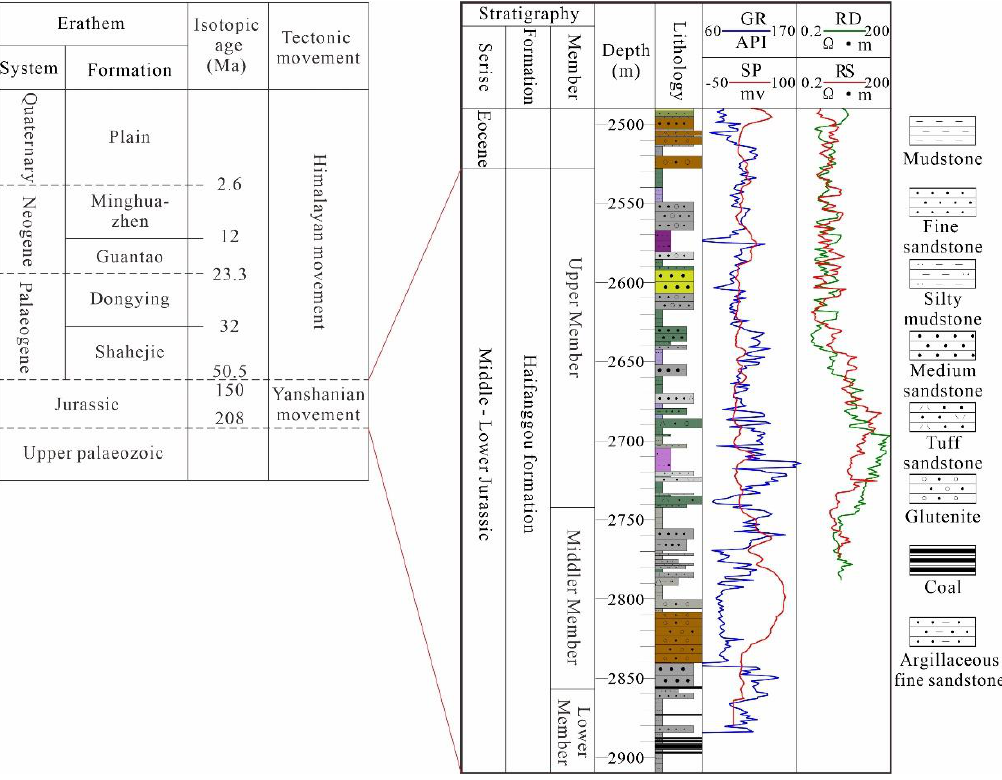
Figure 2. Formation distribution and logging data and lithologic distribution characteristics of a typical well in Qikou Sag (Well Q9 – 1).